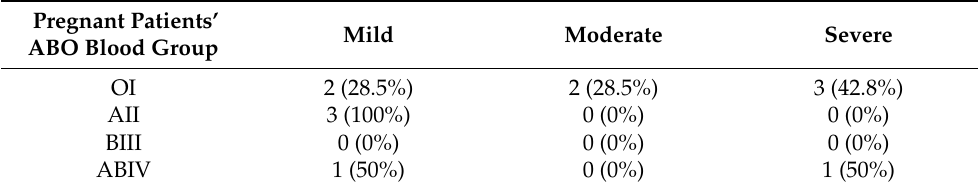
Table A1. Mild, moderate and severe forms of COVID-19 in second and third trimester pregnant patients, according to blood